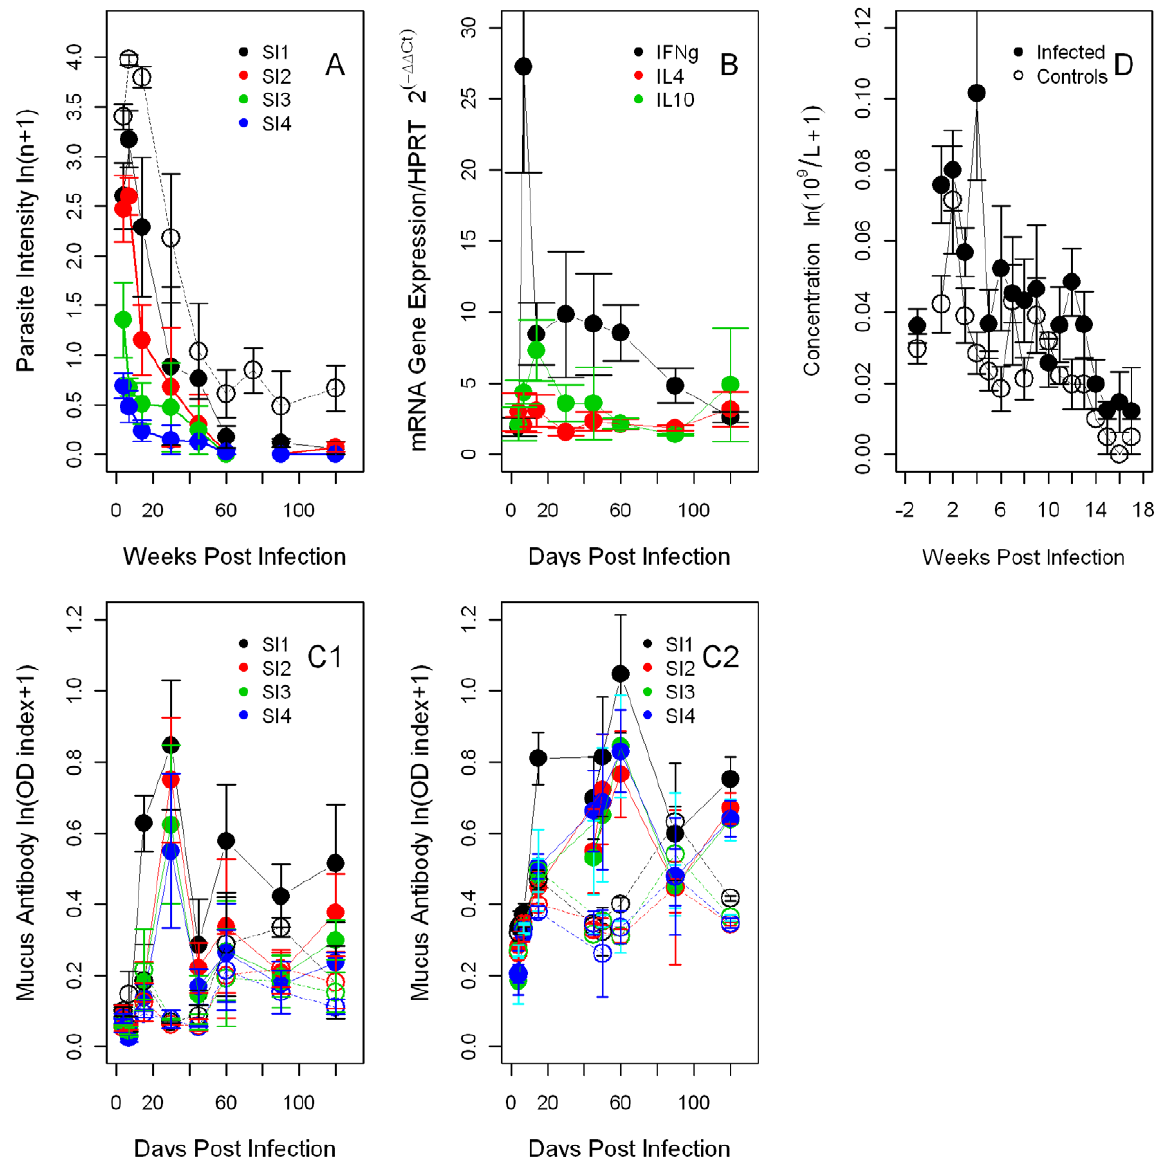
Figure 10. Summary of T.retortaeformis intensity and immune variables from the experimental co-infection. Mean 6 SE during the course of the infection (days or weeks post infection) are reported. A - Helminth intensity in the small intestine sections, from the duodenum (SI-1) to the ileum (SI-4), respectively. The helminth development during the course of the infection is as follows: 4 days post infection (DPI) third stage infective larvae (L3), 7 DPI both L3 and fourth stage larvae (L4), from 14 DPI onwards adult stage only. For comparison, empty black circles represent the helminth intensity in the duodenum from the single infection. B - Expression of cytokines, IFN c , IL4 and IL10 in the duodenum. C - Mucus antibody against adult helminths, IgA (C1) and IgG (C2), from the duodenum to the ileum. D - Peripheral eosinophils. For C and D, infected hosts: full circles, controls: empty circles.